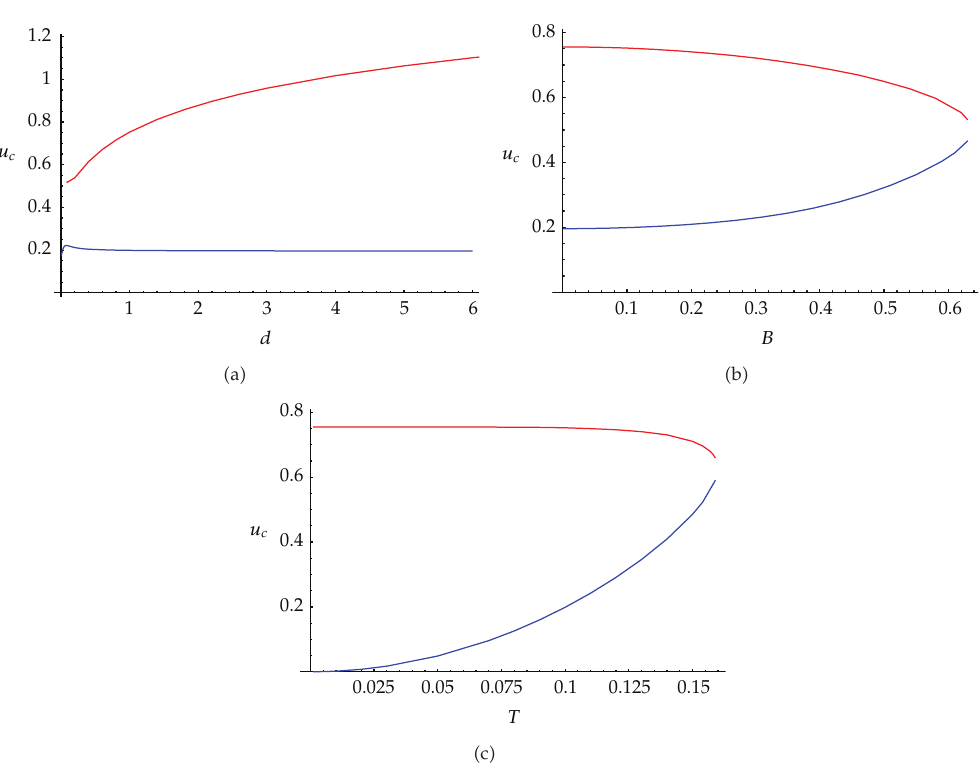
Figure 9: Position u c of the vertex for n s (cid:8) 0 (cid:3) normal baryon (cid:4) and fixed j A (cid:8) 0 as a function of (cid:3) a (cid:4) d with fixed B (cid:8) 0 . 10 , T (cid:8) 0 . 10, (cid:3) b (cid:4) B with fixed d (cid:8) 1 , T (cid:8) 0 . 10, (cid:3) c (cid:4) T with fixed B (cid:8) 0 . 10 , d (cid:8) 1. The lower (cid:3) blue (cid:4) line is the configuration A with u c close to u T , and the upper (cid:3) red (cid:4) line is the configuration B with large separation between u c and u T